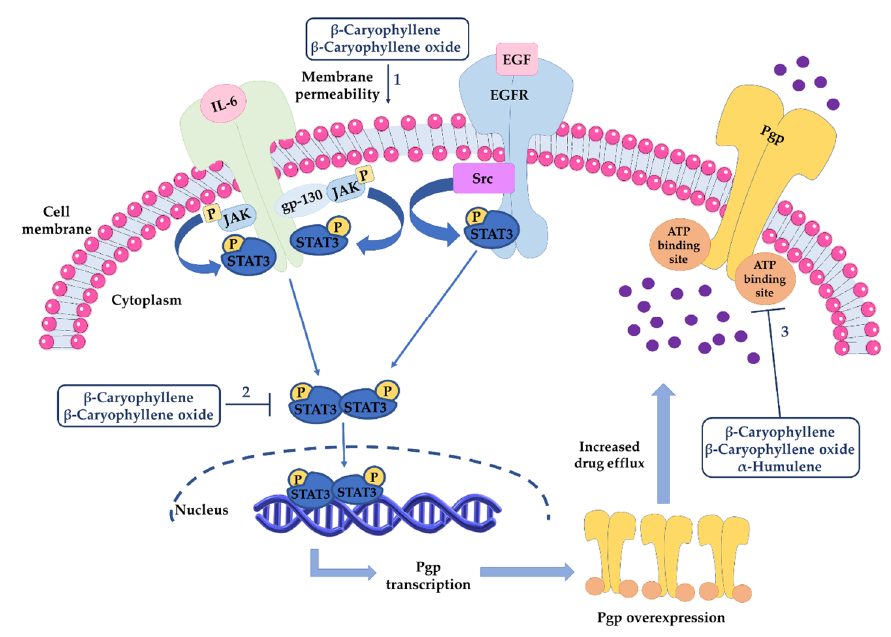
Figure 9. Mechanisms involved in the P-glycoprotein (Pgp) inhibition by caryophyllane sesquiterpenes [162]. (1) Due to their lipophilic nature, they can alter membrane fluidity and alter its